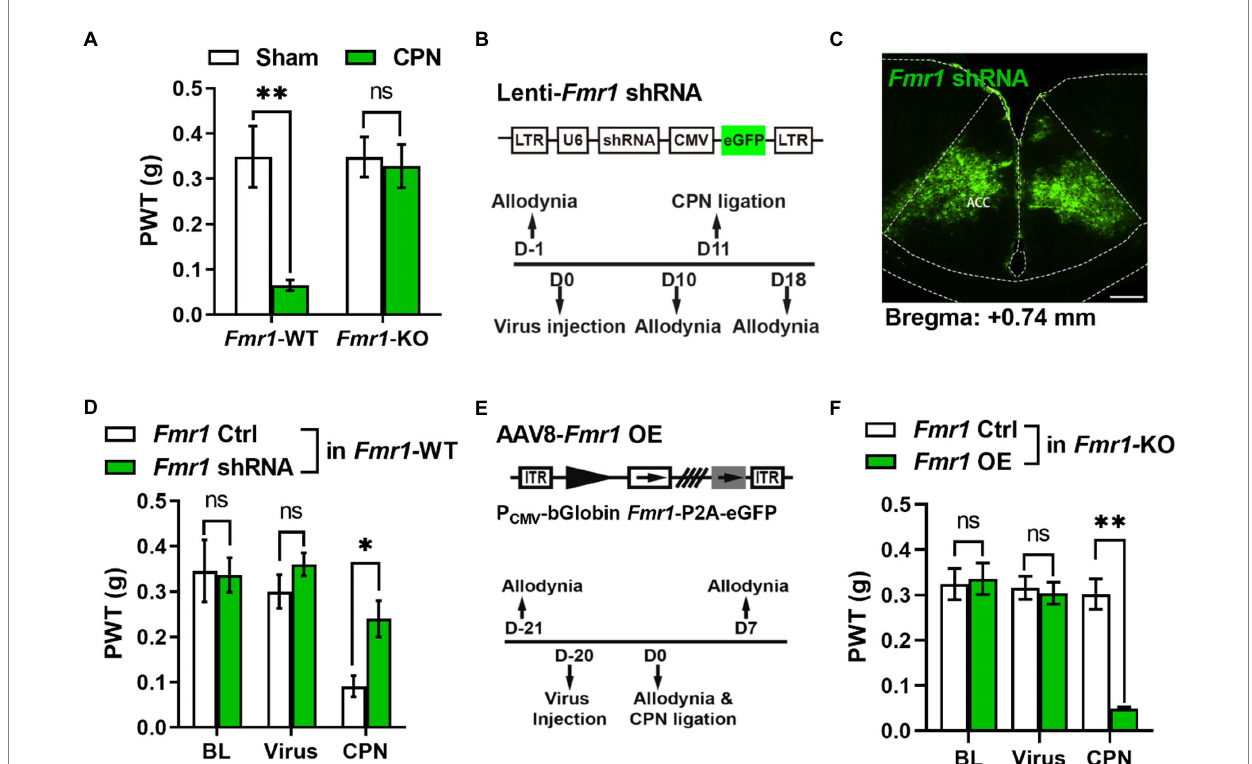
FIGURE 4 Cingulate FMRP is necessary for the development of peripheral hypersensitivity after nerve injury (A) PWT tests after CPN ligation in Fmr1 WT and KO mice (Two-way RM ANOVA, interaction: F (1;11) = 4.90, p < 0.05, Time: F (1;11) = 6.50, p < 0.05, WT vs. KO: F (1;11) = 10.37, p < 0.01; Sham: WT vs. KO, p > 0.05; WT: n = 8, KO: n = 5; “**” indicates p < 0.01). (B) Upper schematics of lentivirus vectors engineered shRNA to knock down Fmr1 and eGFP Ctrl. Lower experimental paradigm for behavioral testing after injection of Fmr1 -shRNA virus into ACC. (C) Illustration of bilateral expression of lenti- Fmr1 shRNA virus in ACC of Fmr1 WT mice (scale bar, 200 μ m). (D) PWT tests in Fmr1 WT mice conducted at BL, after virus injection of either Fmr1 Ctrl or shRNA in ACC, further after CPN ligation (Two-way RM ANOVA, interaction: F (3;30) = 1.43, p > 0.05, Time: F (3;30) = 19.10, p < 0.01, Ctrl vs. shRNA: F (1;30) = 8.24, p < 0.05, n = 6/group; “*” indicates p < 0.05). (E) Upper schematics of AAV8 vector engineered to overexpress Fmr1 and an eGFP Ctrl. Lower experimental paradigm for behavioral testing. (F) PWTs in Fmr1 KO mice detected at BL, after virus injection of either Fmr1 Ctrl or OE in ACC, further after CPN ligation (Two-way RM ANOVA, interaction: F (4;72) = 12.36, p < 0.01, Time: F (4;72) = 16.11, p < 0.01, Ctrl vs. OE: F (1;72) = 102.31, p < 0.01, n = 10/group; “**” indicates p < 0.01). Data are represented as mean ± SEM; ns, not